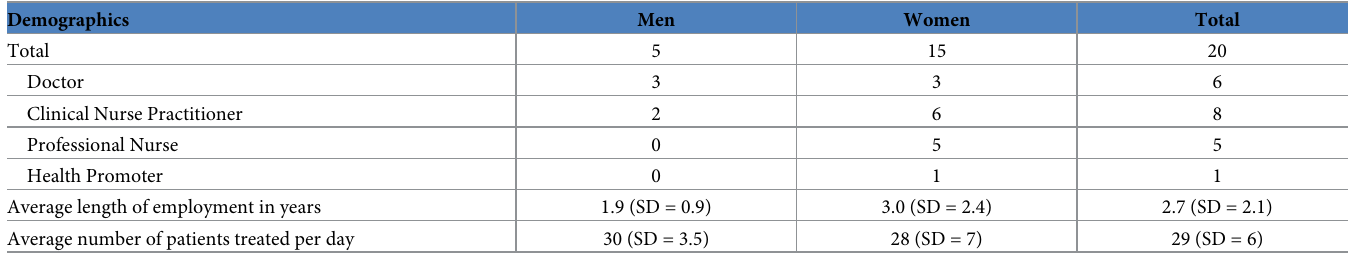
Table 1. Participant